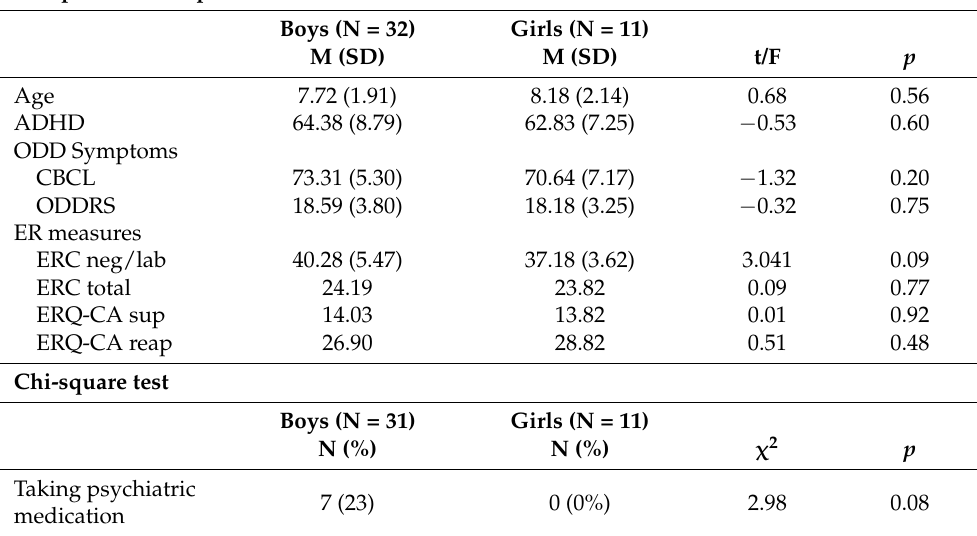
Table 1. Gender Differences at Baseline .